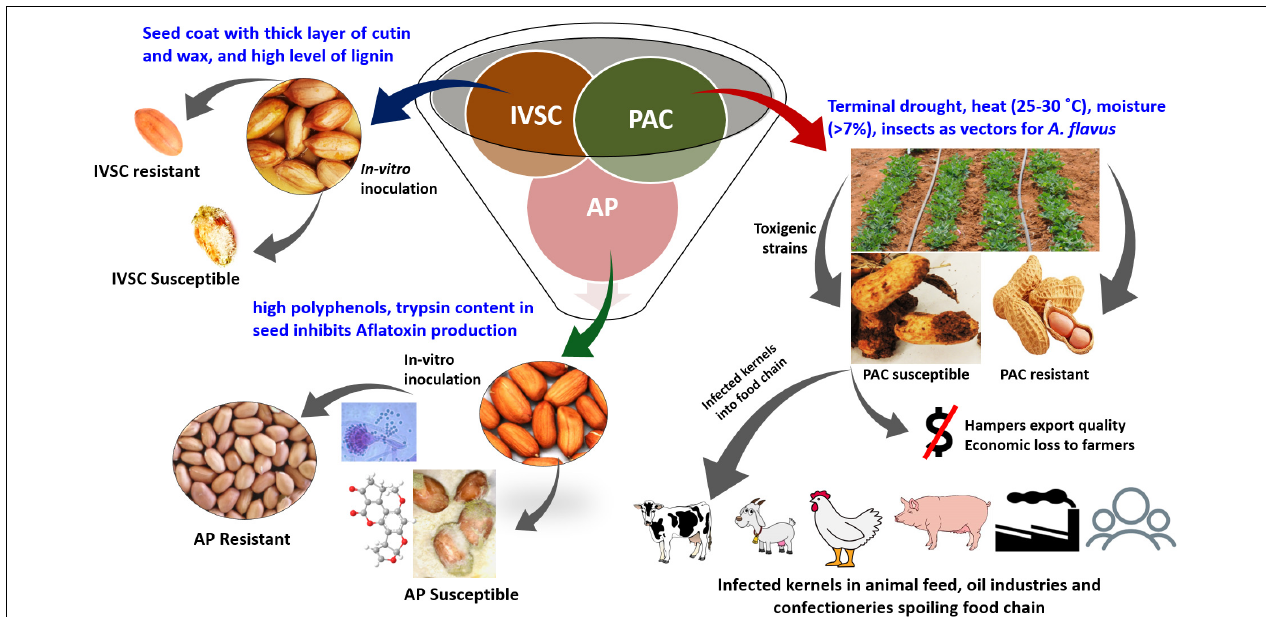
FIGURE 1 | Aflatoxin resistance mechanisms in groundnut. IVSC, in vitro seed colonization; PAC, pre-harvest aflatoxin contamination; AP, aflatoxin